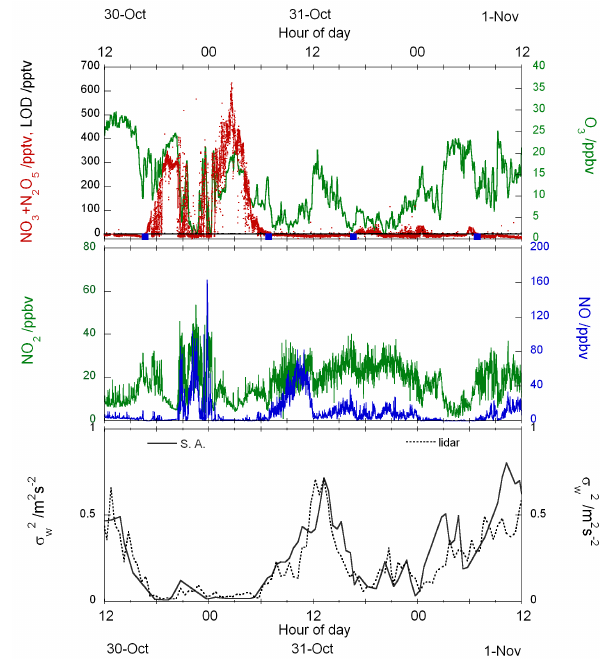
Fig. 5. A detailed plot of the continuous dataset of chemical and physical observations from 12:00 (noon) on 30 October to 12:00 on 1 November 2007. The top panel shows mixing ratios of NO 3 +N 2 O 5 (red), the LOD ∼ 2pptv (black), (temporal resolu- tion=15 s), O 3 mixing ratios (green) (temporal resolution=5min) and approximate sunrise and sunset (blue squares). The middle panel shows mixing ratios of NO (blue) and NO 2 (green), (tem- poral resolution=1 min). The bottom panel shows the variance of w ( σ 2 w ) , (temporal resolution=1h) the vertical velocity component, as measured by the Doppler lidar and ultrasonic anemometer on the BT tower (see text for measurement